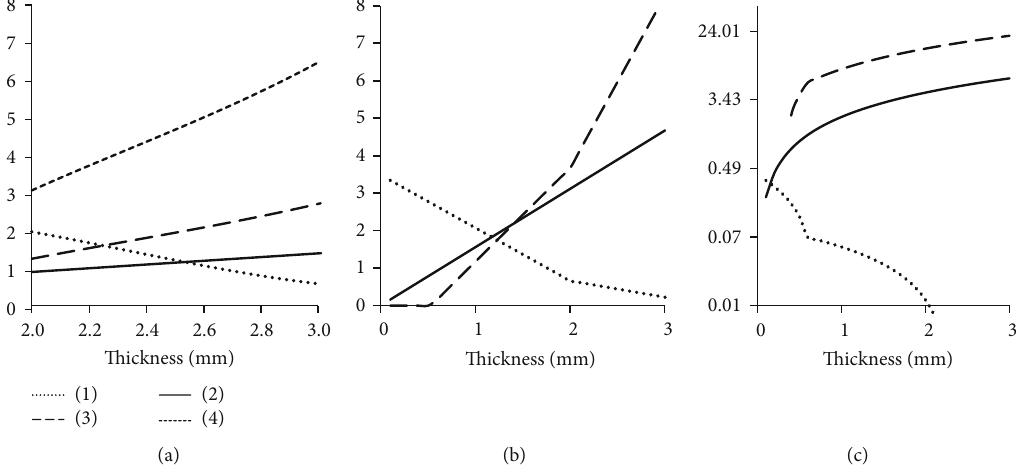
Figure 6: Results of the material durability model: (a) glass; galvanized steel: (b) plain sheet, (c) bowed shape; 1 maximum bending (mm); 2 weight (kg); 3 factor of safety; 4 factor of safety for reinforced glass.